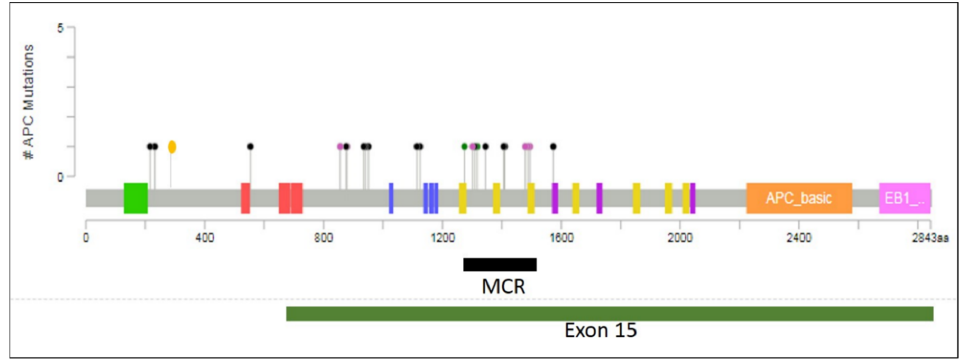
Figure 2. APC mutations found in EOCRC samples mapped to their position within the protein. Each lollipop represents the position of a mutation with the colours of the lollipop representing different types of mutation: black, nonsense mutations; green, missense mutation; pink, frameshift mutation; yellow, splice variant. While a high proportion of mutations occur within the mutation cluster region (MCR, black bar), mutations are found throughout the first 1600 codons of APC including some upstream of exon 15 (green bar). Protein domains: green, oligomerisation; red, armadillo repeats; blue, 15 amino acid repeats; yellow, 20 amino acid repeats; purple, SAMP motif. The plot was generated using Mutation Mapper (www.cbioportal.org) and manually curated.